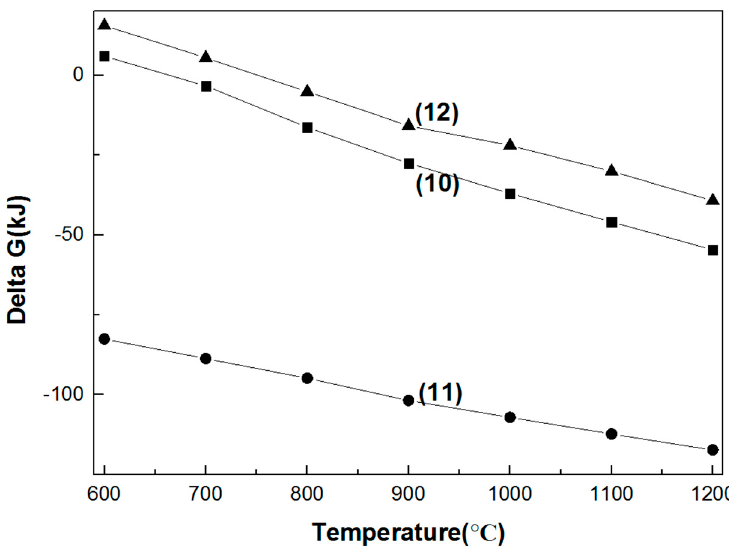
Figure 7. Gibbs free energy of the reaction between Na 2 CO 3 and the three metal oxides in the 600– 1200 °C temperature range. (10) Na 2 CO 3 + Al 2 O 3 = Na 2 O·Al 2 O 3 + CO 2 ; (11) Na 2 CO 3 + l/2Cr 2 O 3 + 3/4O 2 = Na 2 CrO 4 + CO 2 ; (12) Na 2 CO 3 + Fe 2 O 3 = Na 2 O·Fe 2 O 3 + CO 2 .